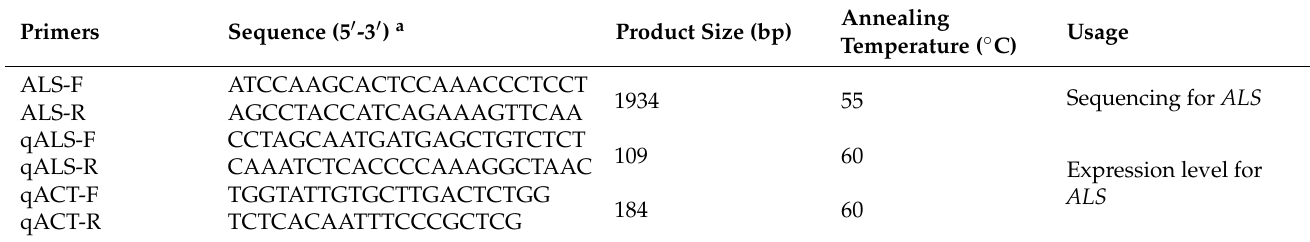
Table 2. The corresponding primers used to amplify and expression levels of ALS gene in C. difformis